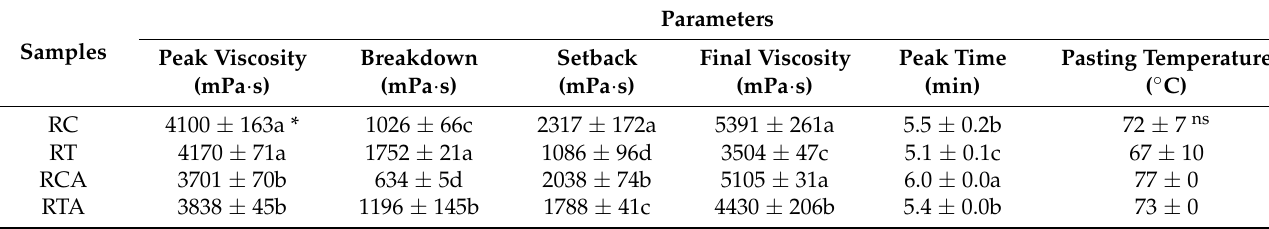
Table 2. Viscometric properties of GF